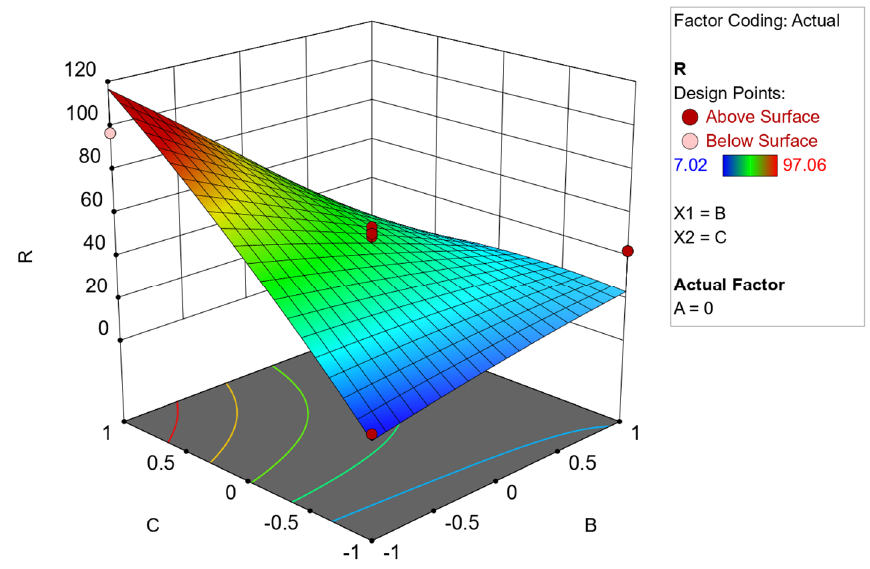
Figure 11. Response surface plot showing the interaction and influence of the initial copper ions concentration (B) and contact time (C) on the adsorption rate (R).